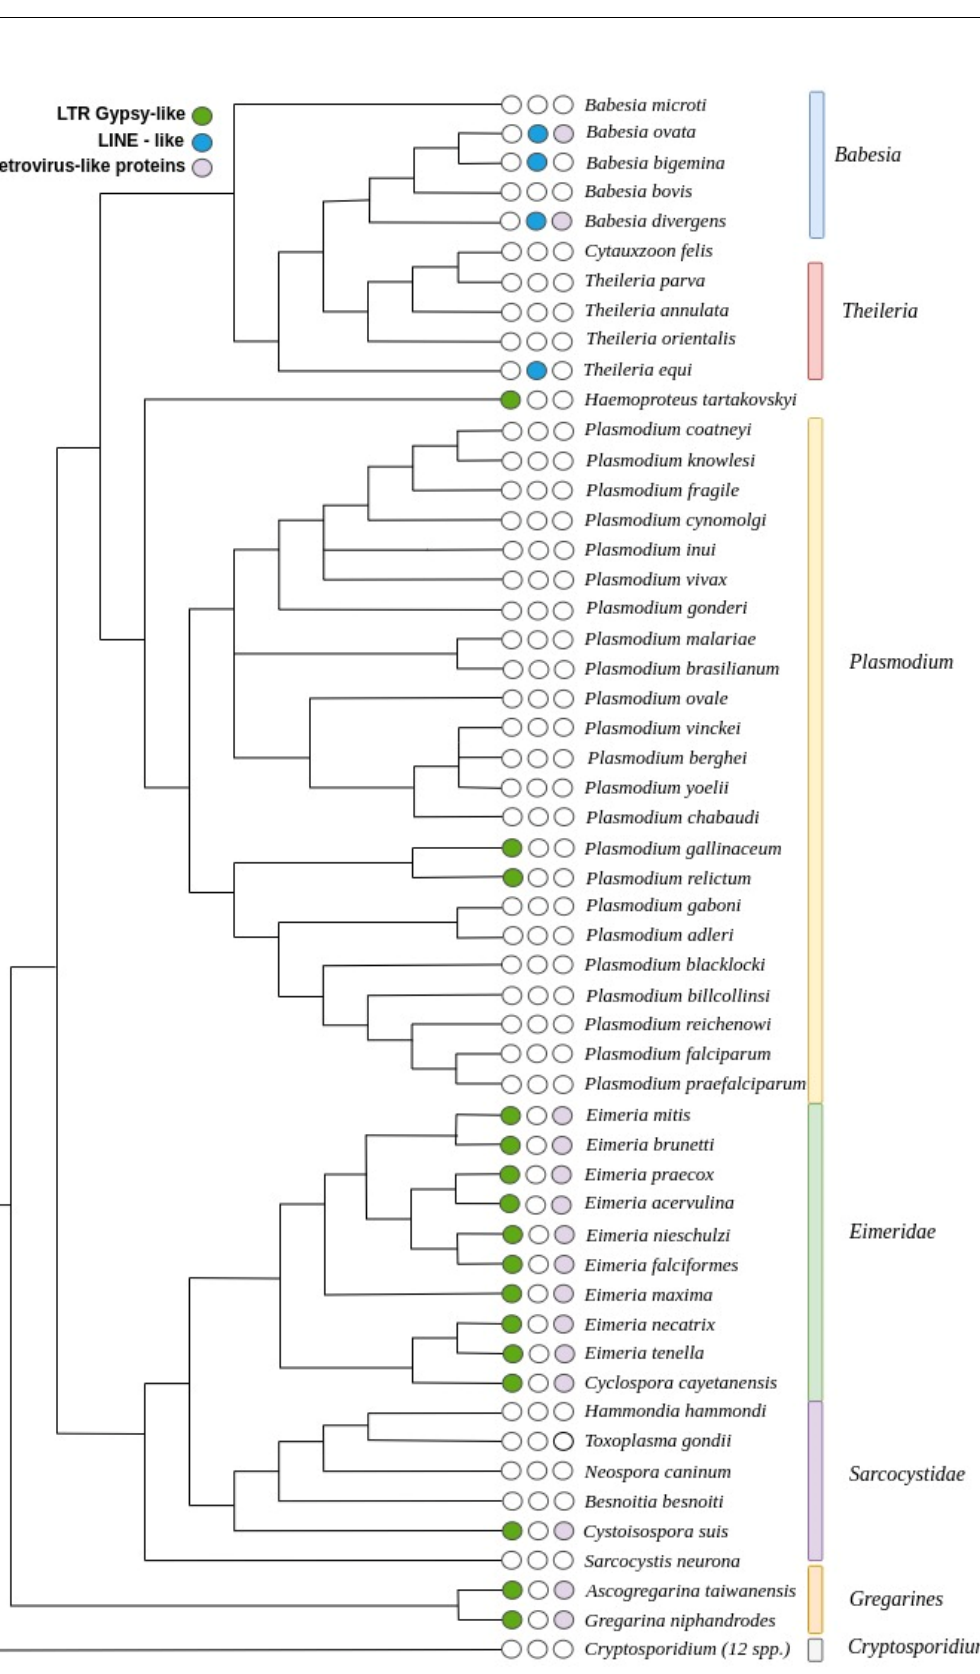
Figure 5. Proposed Apicomplexa phylogenetic tree based on Arisue et al. [31], Janouskovec et al. [32], Mathur et al. [10], and Wasmuth et al. [12], showing the distribution of the main TEs in this phylum.